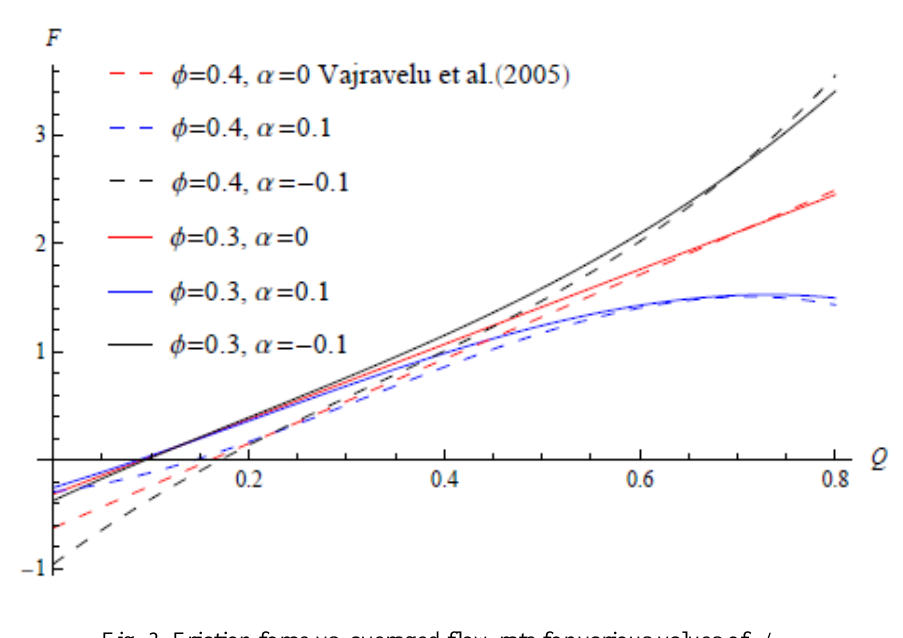
Fig. 3. Friction force vs. averaged flow rate for various values of ,  